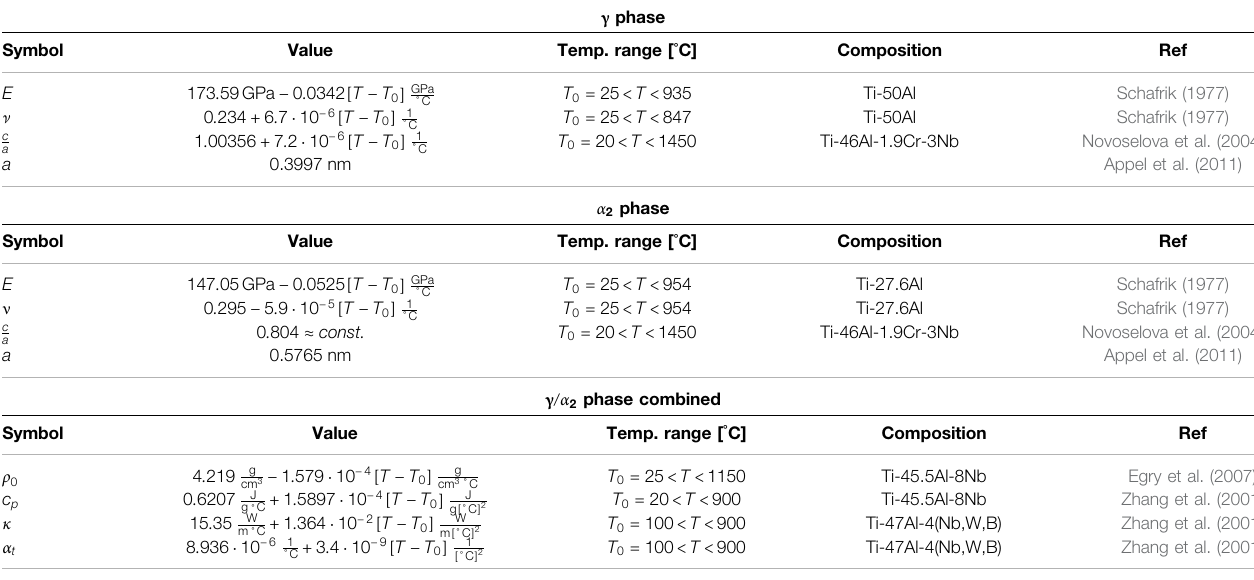
TABLE 3 | Thermoelastic model parameters used in this study. The reported experiments were carried out in the indicated temperature range. Where necessary, the linear approximationsofthetemperature dependences areextrapolatedtothetemperaturesofinterest. Ifno parameters for thesingle phases areavailable, theparametersof twophasealloyswereusedinstead.Thelatticeconstants a andthe c ratiosoftheunitcellsarenecessarytocalculatethe(temperature dependent)magnitudeoftheBurgers a vectors and the corresponding slip/twinning directions s and slip/twinning plane normals n as described elsewhere Schnabel (2018).